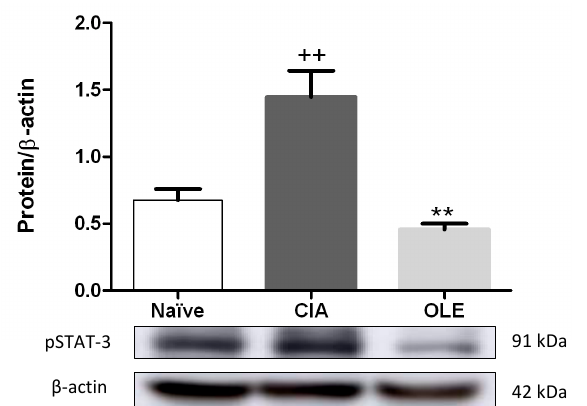
Figure 7. OLE supplemented diet regulated pSTAT-3 in hind paws homogenates from arthritis induced mice. The expression of pSTAT-3 was measured by Western blotting and normalized with respect to β -actin (house-keeping). Western blot images are representative of separate experiments with similar results. Naïve group, non-arthritic control animals fed with SD; CIA, control group induced arthritic animals fed with SD; OLE induced arthritic animals fed with OLE enriched diet (0.025% w/w ). Values represented mean ± S.E.M ( n = 8), ++ p < 0.01 vs. Naïve control group; ** p < 0.01 vs. CIA group.